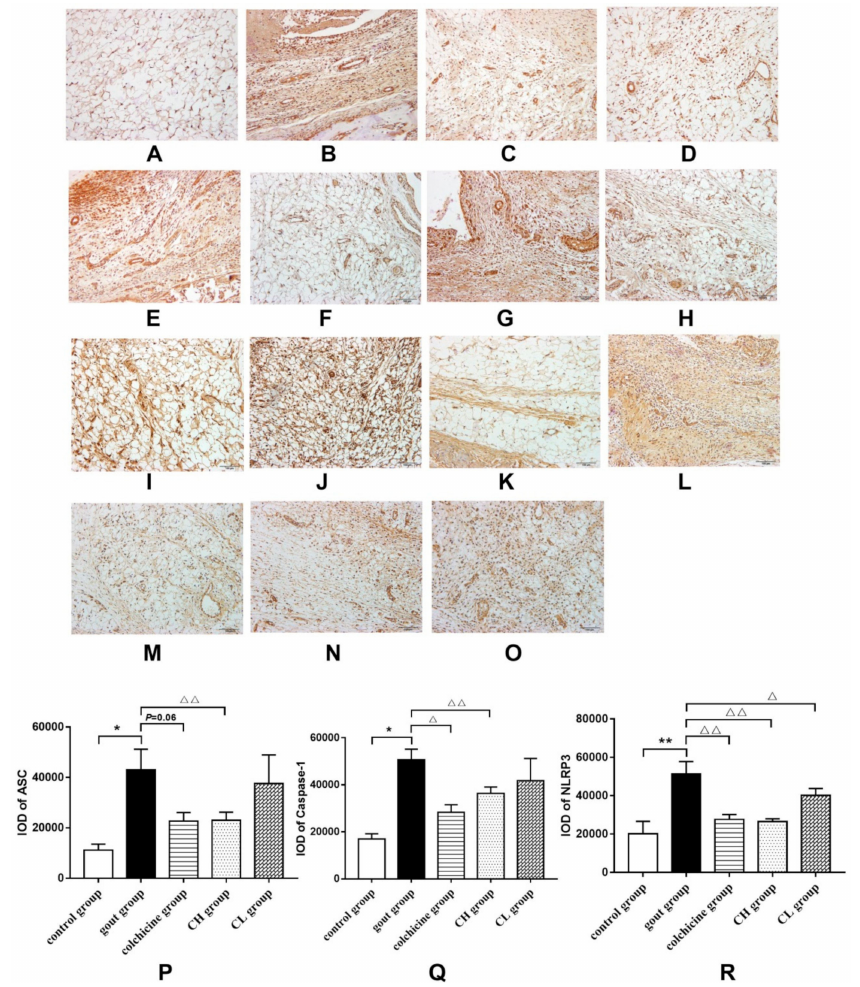
Figure 4. E ff ect of chicory extract on expressions of inflammasome components in ankle synovial tissues of MSU-induced gout rats: ( A – E ) ASC IHC stain, ( F – J ) caspase-1 IHC stain, ( K – O ) NLRP3 IHC stain, ( P ) protein expression levels of ASC, ( Q ) protein expression levels of caspase-1, and ( R ) protein expression levels of NLPR3. 200 × magnification. Data are expressed as mean ± SD for six rats in each group. * p < 0.05, ** p < 0.01 vs. control group. (cid:52) p < 0.05, (cid:52)(cid:52) p < 0.01 vs. gout